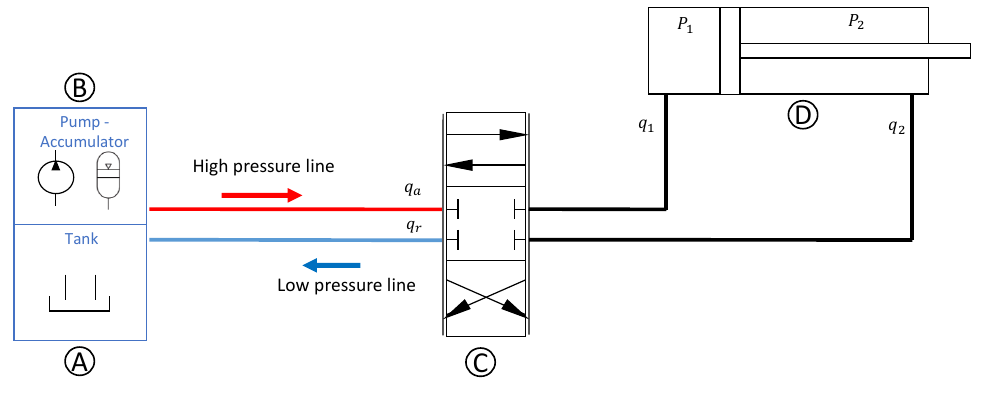
Figure 4. Schematic of the Hydraulic Load Generation